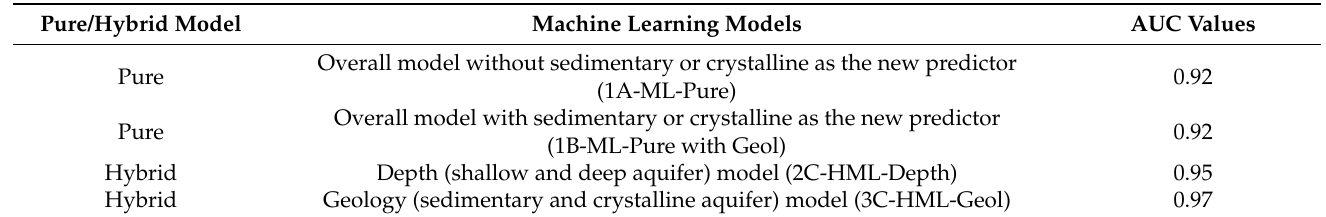
Table 4. Comparison of the AUC values of two pure overall and two hybrid depth and geology models based on their combined testing